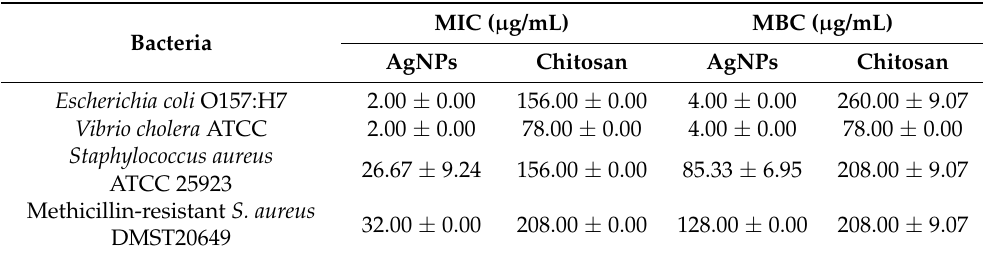
Table 2. Minimum inhibitory concentration (MIC) and minimum bactericidal concentration (MBC) of AgNPs and Chitosan against bacteria by serial dilution plate count assay. MIC ( µ g/mL) MBC ( µ g/mL) Bacteria AgNPs Chitosan AgNPs Chitosan Escherichia coli O157:H7 2.00 ± 0.00 156.00 ± 0.00 4.00 ± 0.00 260.00 ± 9.07 Vibrio cholera ATCC 2.00 ± 0.00 78.00 ± 0.00 4.00 ± 0.00 78.00 ± 0.00 Staphylococcus aureus 26.67 ± 9.24 ATCC 25923 Methicillin-resistant S. aureus